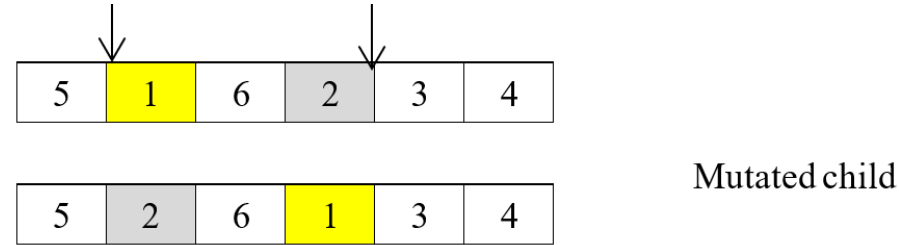
Figure 3. Mutation operation for each parent.